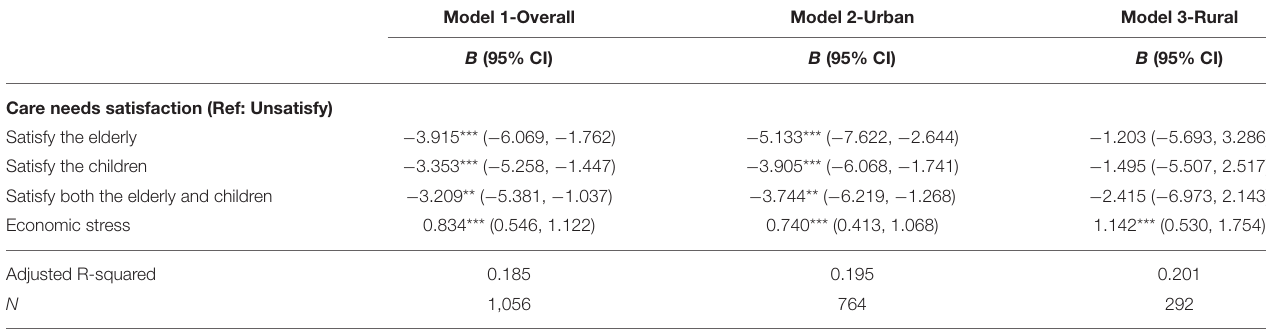
TABLE 3 | Multiple liner regression analysis of the relationship between family care needs satisfaction, economic stress and depressive